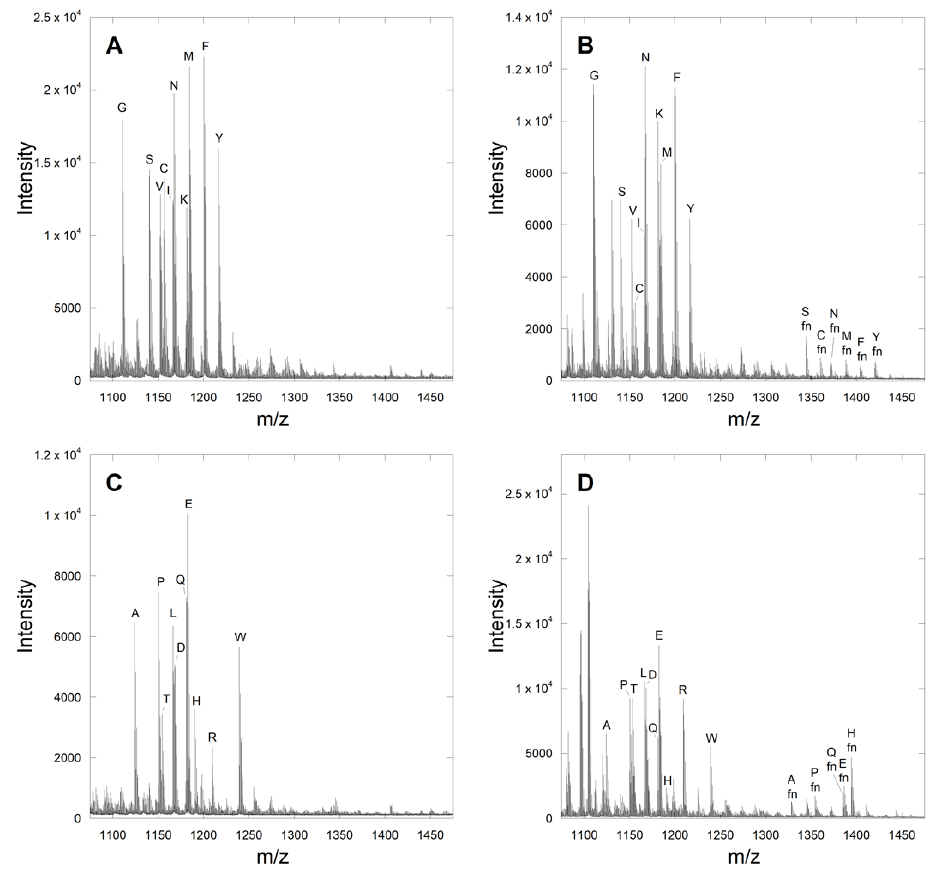
Figure 3. Farnesylation of DsGRAGCa 1 IIM libraries. Library 1 ( A ) before and ( B ) after farnesylation with 1 µM yFTase. Library 2 ( C ) before and ( D ) after farnesylation with 1 µM yFTase. The identity of the residue in the X position is indicated with the letter above each peak. The farnesylated peptides are highlighted with the designator “fn”.